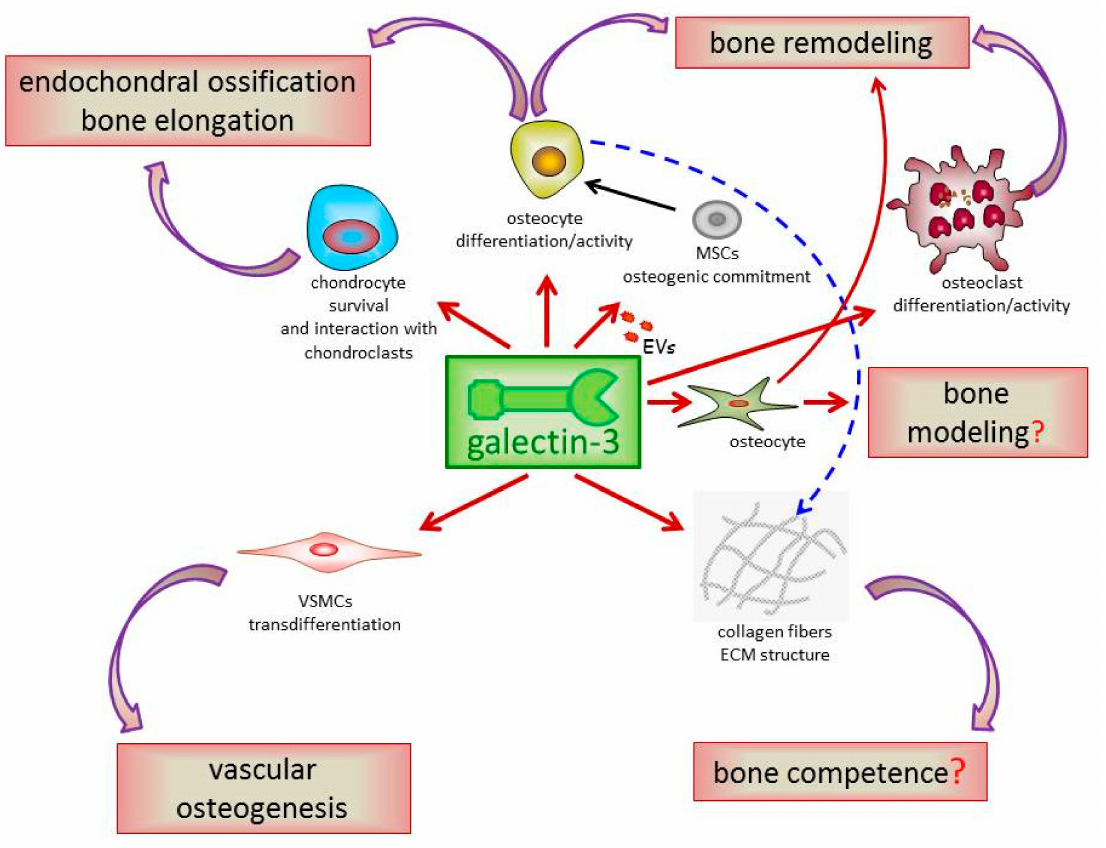
Figure 1. Galectin-3 osteogenic activities in bone and vascular tissue. Galectin-3 is considered a marker of chondrogenic and osteogenic cell lineages and is up-regulated in conjunction with other osteogenic markers during differentiation of bone cells. Consistent with a role in bone physiology, galectin-3 deficiency affects endochondral ossification and bone remodeling. Galectin-3 is also critical for maintaining proper extracellular matrix (ECM) structure and, possibly, bone competence. Being also expressed by osteocytes, it is possible to hypothesize its participation in the regulation of mechanosensory function of these cells and promotion of bone modeling and remodeling also through this mechanism. Finally, galectin-3 activity is central for vascular smooth muscle cells (VSMCs) transdifferentiation into an osteoblast-like phenotype and vascular osteogenesis. EVs = extracellular vesicles; MSCs = mesenchymal stem